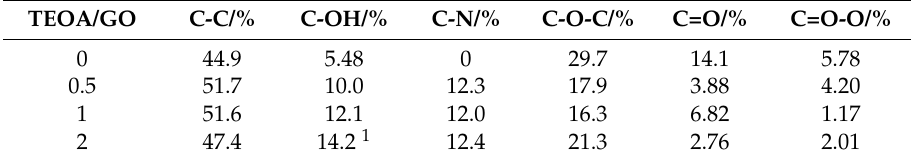
Table 1. The relative atomic percentages of the chemical groups in GO and GO-TEOA membranes. TEOA/GO